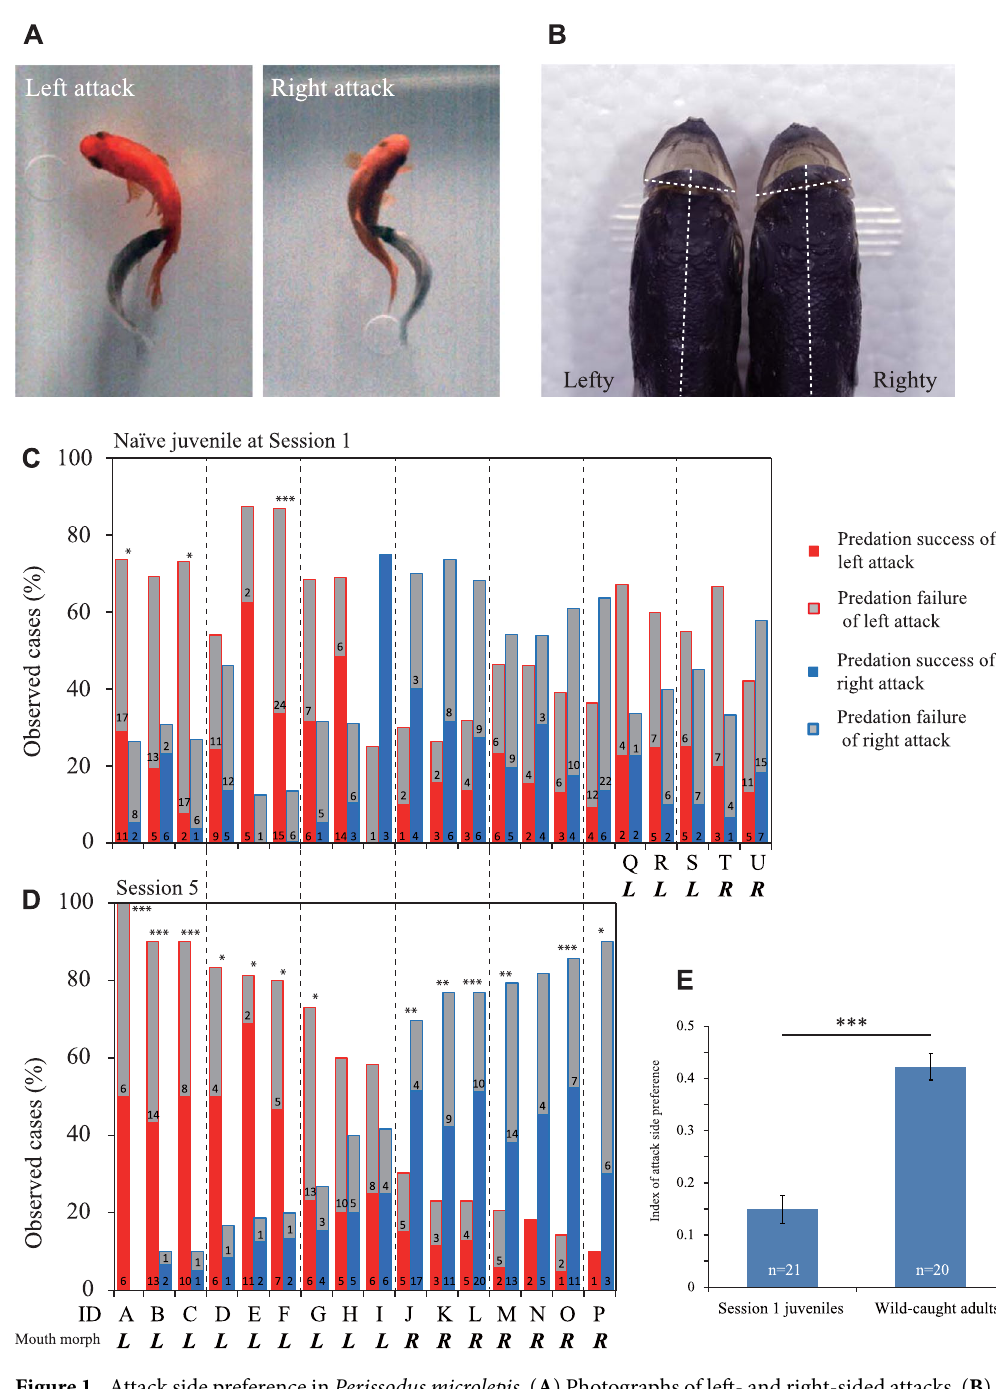
contact area between the predator’s teeth and the prey’s trunk 26 . In fact, scale-eaters with more strongly skewed mouths eat more scales in the field 27 . The maximum angular velocity and amplitude of body flexion during a predatory attack, as observed in experiments with fish in tanks, is higher when a cichlid attacks on the dominant